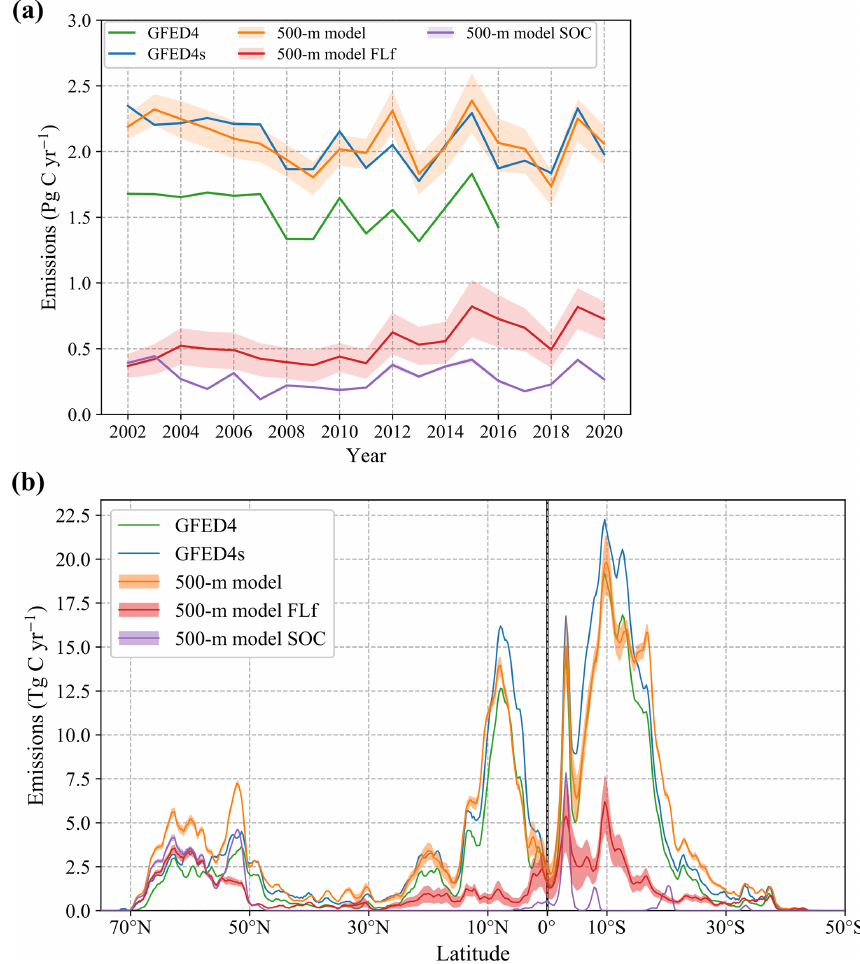
Figure 8. Annual global emissions for the 500m model for 2002–2020 versus GFED4s for the same time period and GFED4 for 2002–2016 as (a) time series and (b) latitudinal total emissions. Contributions to 500m model emissions from fire-related forest loss (FLf) and SOC burning are displayed separately. Note that these subcategories partly overlap: fire-related forest loss emissions include part of SOC burning emissions and vice versa. Transparent bands around estimates show the range between minimum- and maximum-probability fire-related forest loss. All lines in panel (b) are based on 0.25 ◦ aggregated data and smoothed using a moving-average filter with a window size of four grid cells, i.e. 1 ◦